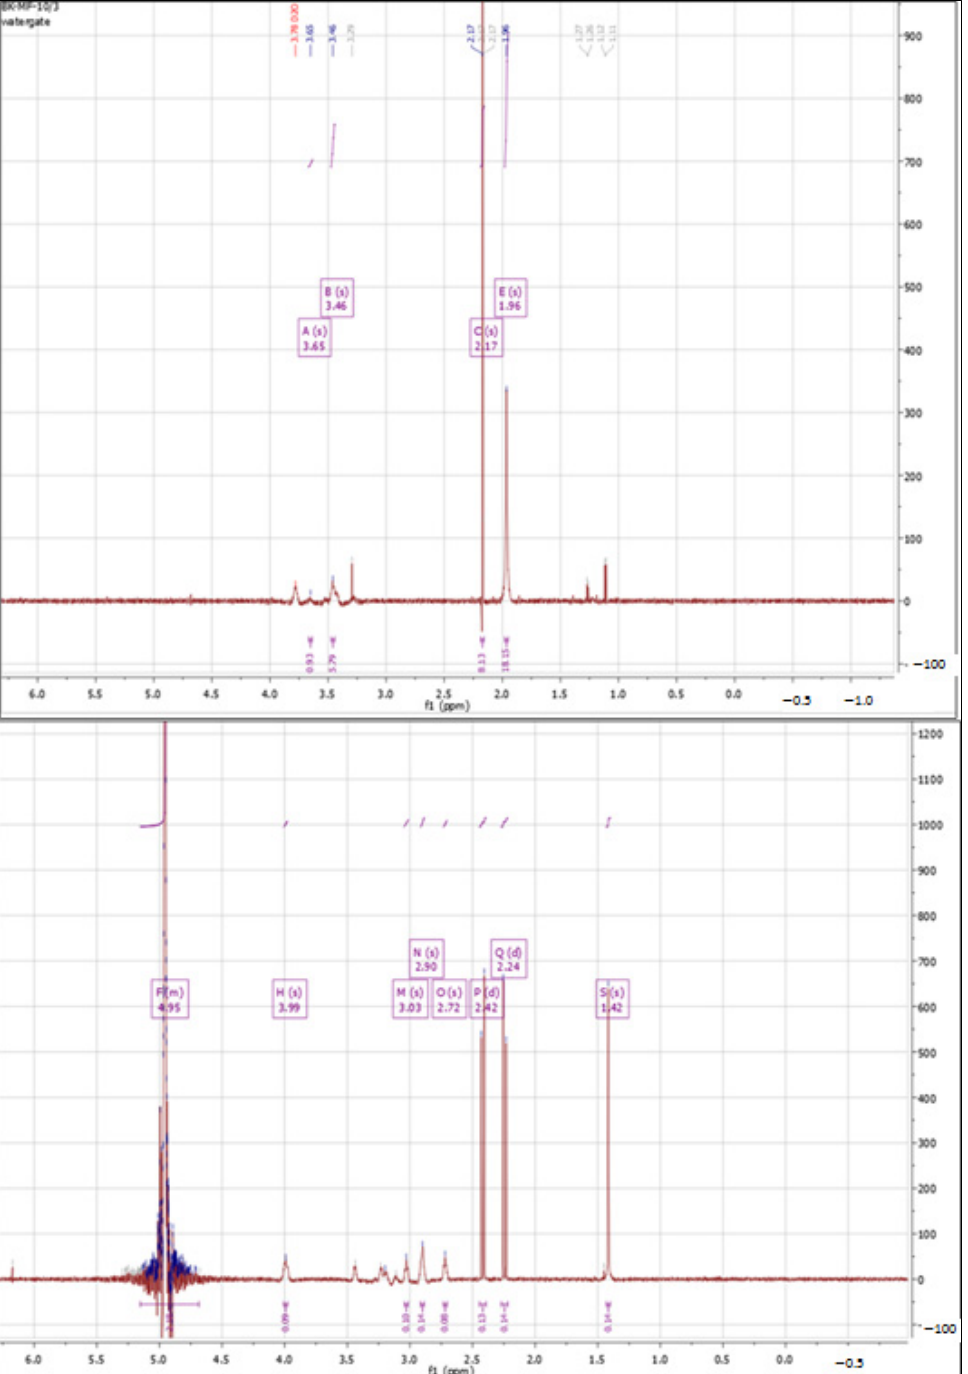
Figure 5. 1 H NMR spectra of native HA ( top ) vs. HA cross-linked with 20% citric acid via Procedure II ( bo tt om ).